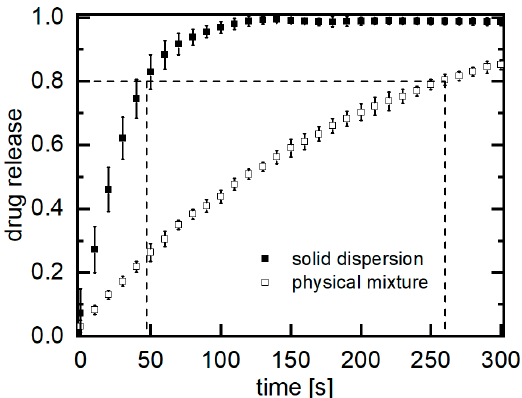
Figure 5. Dissolution profiles of submicron naproxen particles in xylitol [ t 80 = 46 s] and the unprocessed naproxen-xylitol physical mixture [ t 80 = 257 s], av ± CI, α = 0.05, n = 6.